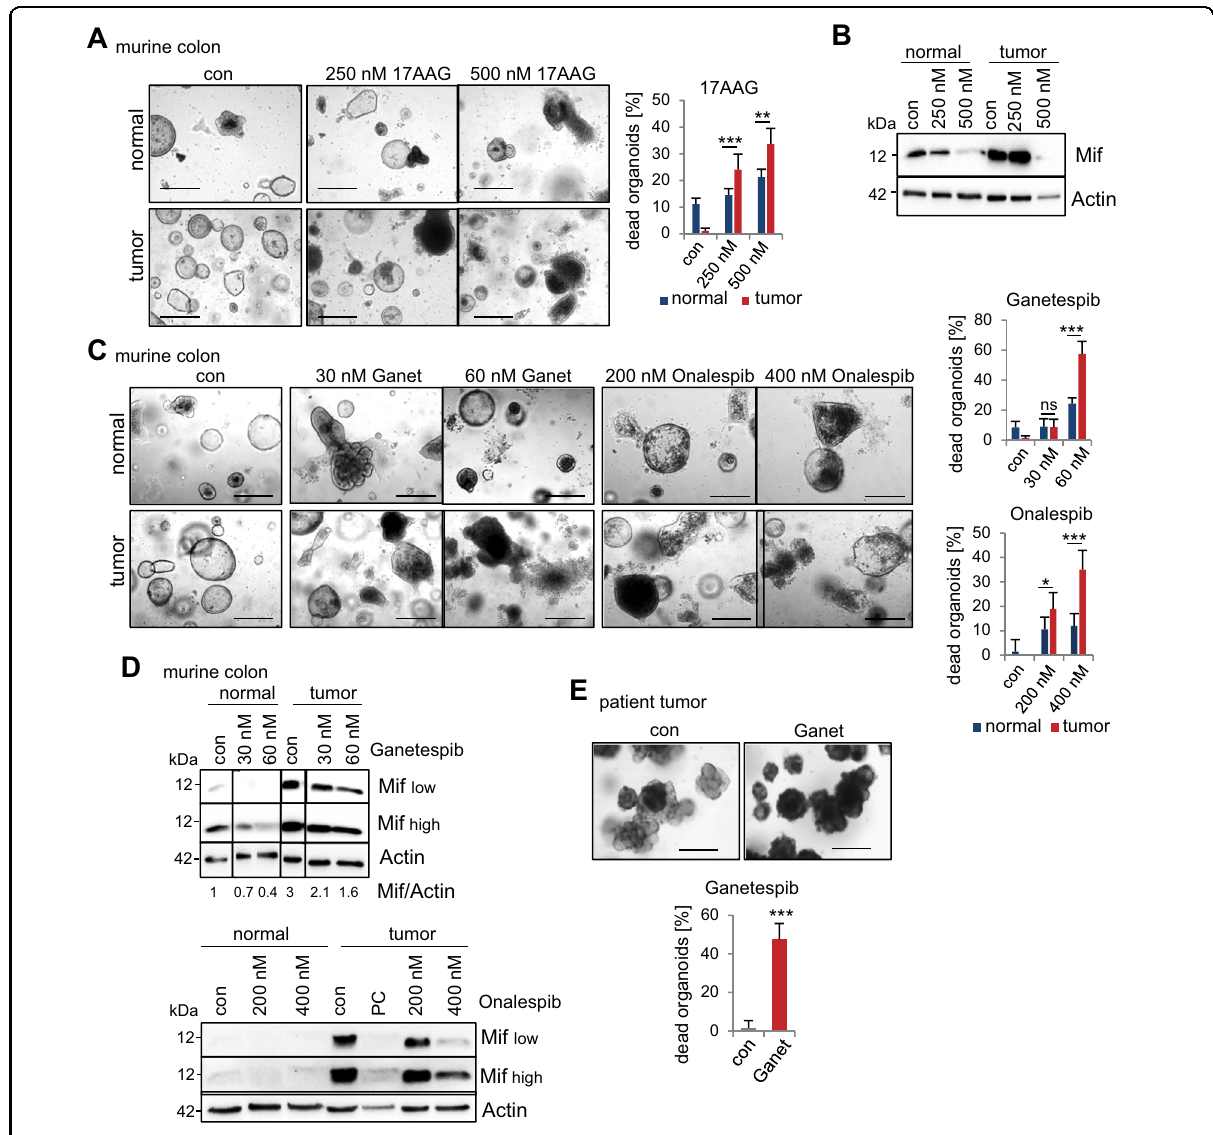
Fig. 7 MIF is an actionable and selective therapeutic target via Hsp90 inhibition in CRC-derived organoids. A , C Therapeutic selectivity of Hsp90 inhibitors. Representative images show colonic organoids derived from matched pairs of pooled Mif + / + tumors or their adjacent epithelium ( ‘ normal ’ ). The indicated organoids were treated with DMSO ( ‘ con ’ ), 17AAG ( A ), Ganetespib ( ‘ Ganet ’ ), or Onalespib ( C ) at the indicated concentrations for 21 h. Scale bars, 200 µm. (Right) Quanti fi cations based on organoid morphology. At least 6 images from ≥ 5 gel domes (×4 magni fi cation each) per group were counted. For each group, number of dead organoids was calculated by the number of total organoids. The data are presented as the means ± SD from different images. B , D Hsp90 inhibitor treatment as described in ( A , C ) of matched pairs. Immunoblot analysis was performed to evaluate Mif degradation. ‘ Mif high ’ and ‘ Mif low ’ indicate exposure times during signal acquisition. Actin, loading control. PC, positive control. Mif/ Actin, Mif expression ratios compared to Actin. E Representative images and quanti fi cation of organoids from patients with resectable CRC treated with 80 nM Ganetespib for 21 h. Scale bars, 200 µm. Quanti fi cation was performed as described in ( A ). Five images (×10 magni fi cation) per condition were quanti fi ed. Means ± SD from different images. A , C , E Student ’ s t test was performed for comparison of indicated groups; * p ≤ 0.05, ** p ≤ 0.01, *** p ≤